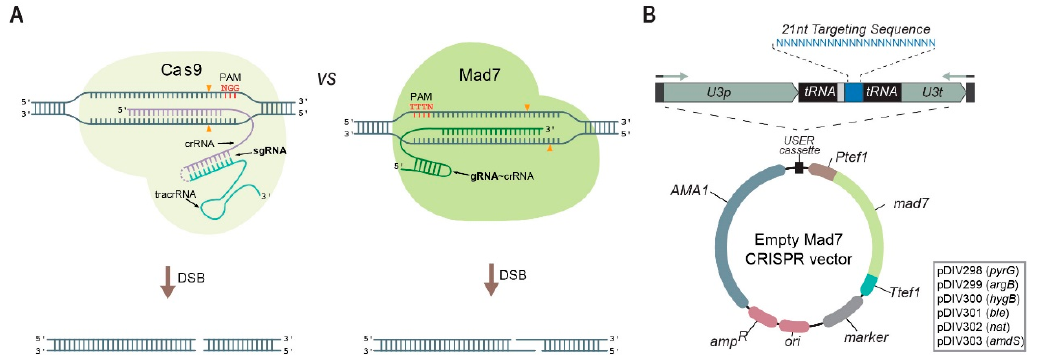
Figure 1. A Mad7 system for genetic engineering of fungi. ( A ) Schematic representations of Cas9 (left) and Mad7 (right) CRISPR nucleases. Scissile bonds in the target sequences are marked with orange triangles [24,25]. The positions of PAM sequences, as well as the orientation and the pairing of the sgRNA of Cas9 (fusion of tracrRNA and crRNA is indicated by the dotted line) and the gRNA of Mad7 (note that Mad7 has a natural single gRNA(=crRNA)) to the target template, are shown. ( B ) Mad7 vectors available for fungal genetic engineering. The vectors are shuttle vectors that can propagate in E. coli using ampicillin selection and in fungi using the AMA1 sequence and one of the selection markers indicated in the box. All vectors contain a mad7 gene and a USER cassette for insertion of the gRNA encoding gene by e.g., USER fusion of two PCR fragments, see Figure S1. Expression of the gRNA gene results in a composite transcript where the gRNA is released by the endogenous tRNA maturation machinery; see text for details.